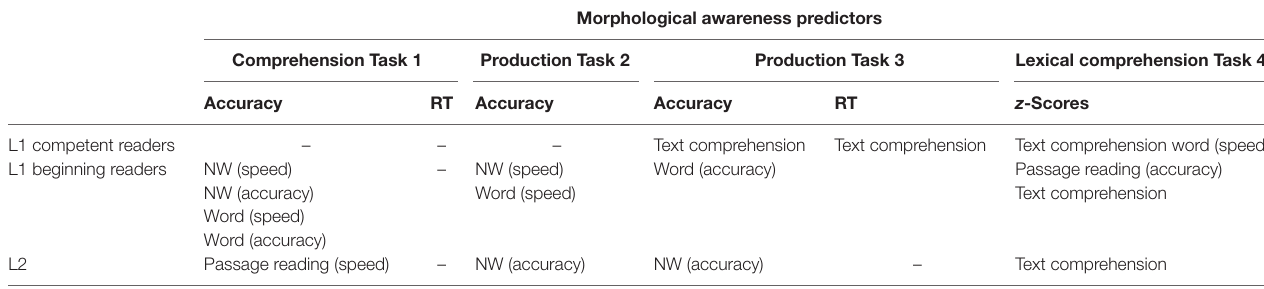
TaBle 3 | Summary of the results of the GLMs that were conducted to test the predictive role of morphological awareness variables on reading skills.